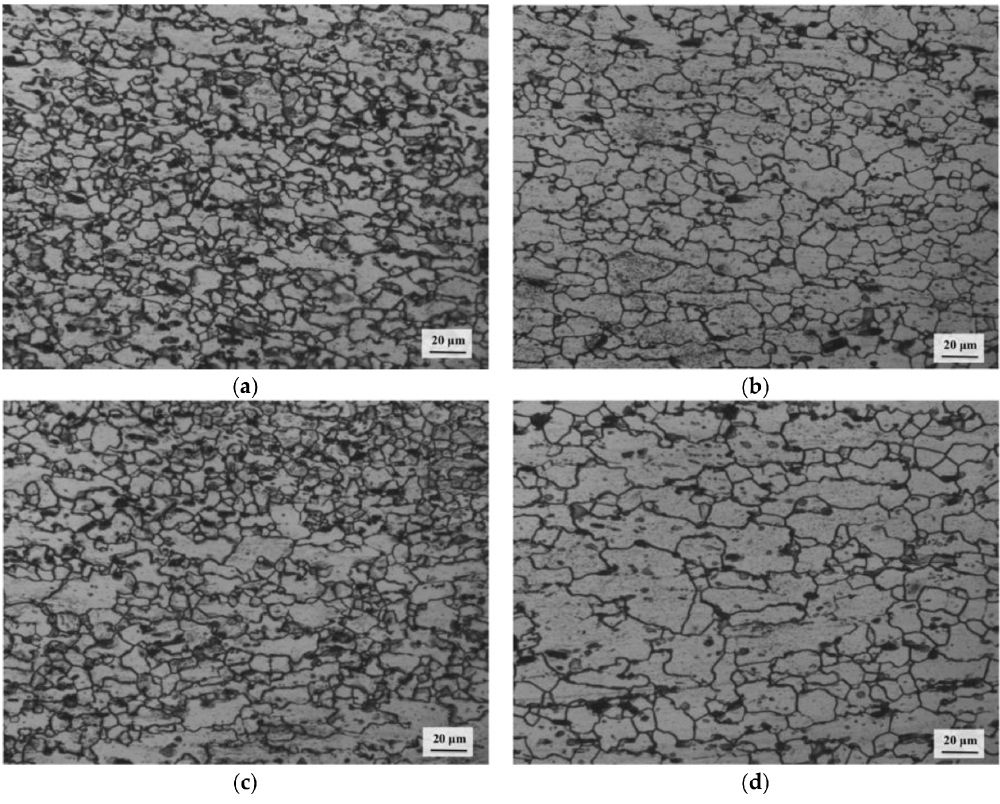
Figure 11. Optical microstructures of specimens deformed at conditions corresponding to Domain 3, revealing DRX features. The compression axis is vertical. ( a ) 400 ◦ C and 0.001 s − 1 ; ( b ) 450 ◦ C and 0.001 s − 1 ; ( c ) 400 ◦ C and 0.0003 s − 1 ; ( d ) 450 ◦ C and 0.0003 s − 1